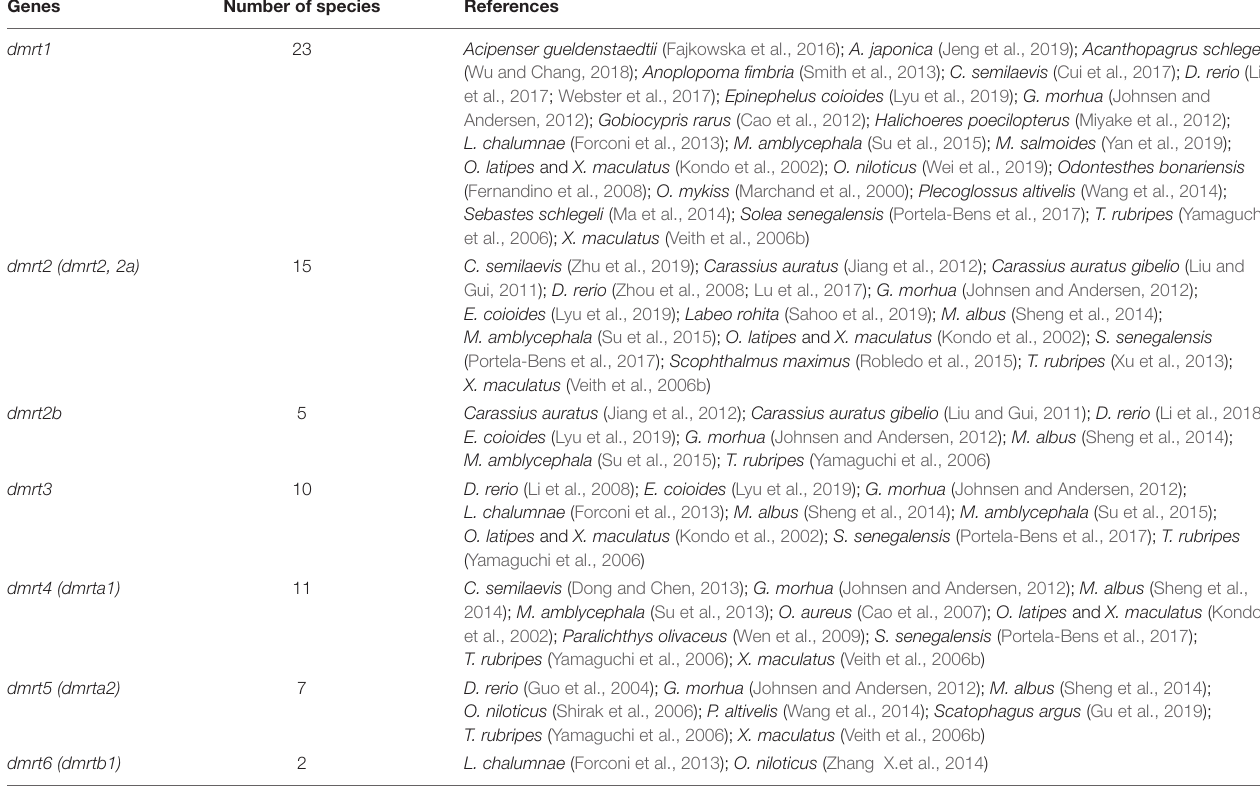
TABLE 3 | The relevant references for dmrt family genes in fish. Genes Number of